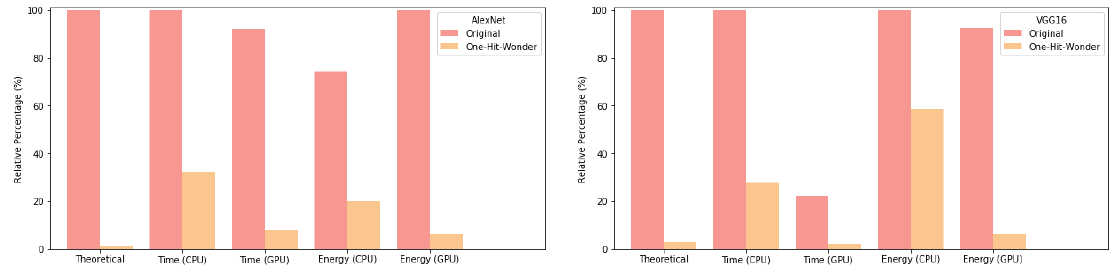
Figure 8. Barcharts for AlexNet and VGG16, illustrating the difference between the theoretical, CPU and GPU efficiency with respect to their computational speed and energy consumed on the Scene15